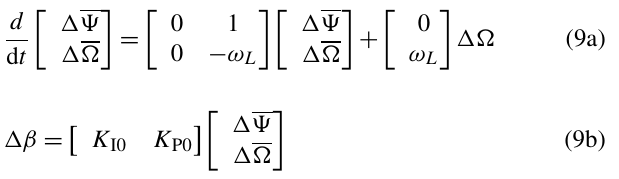
Figure 10. A phasor diagram of the controller dynamics for gain scheduling (on the left) outside the integral and (on the right) in- side the integral. The magnitudes and phases are normalized with respect to the shaft speed input; the dashed gray line indicates the unit circle.